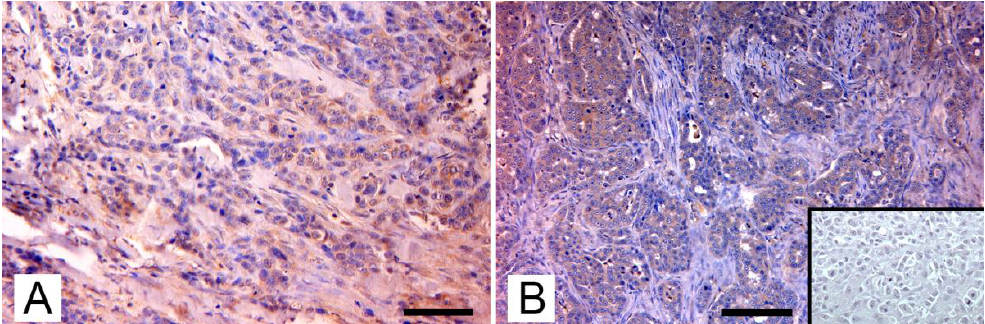
Figure 2. Immunohistochemical expression of p14 MMTV env protein in feline mammary carcinomas: ( A ) Mammary carcinoma. Weak cytoplasmatic immunostaining in neoplastic epithelial cells (arrows; IHC, bar = 50 μ m); ( B ) Mammary carcinoma. Diffuse intense cytoplasmic staining of neoplastic cells (arrows), which form tubular structures and solid growth patterns.